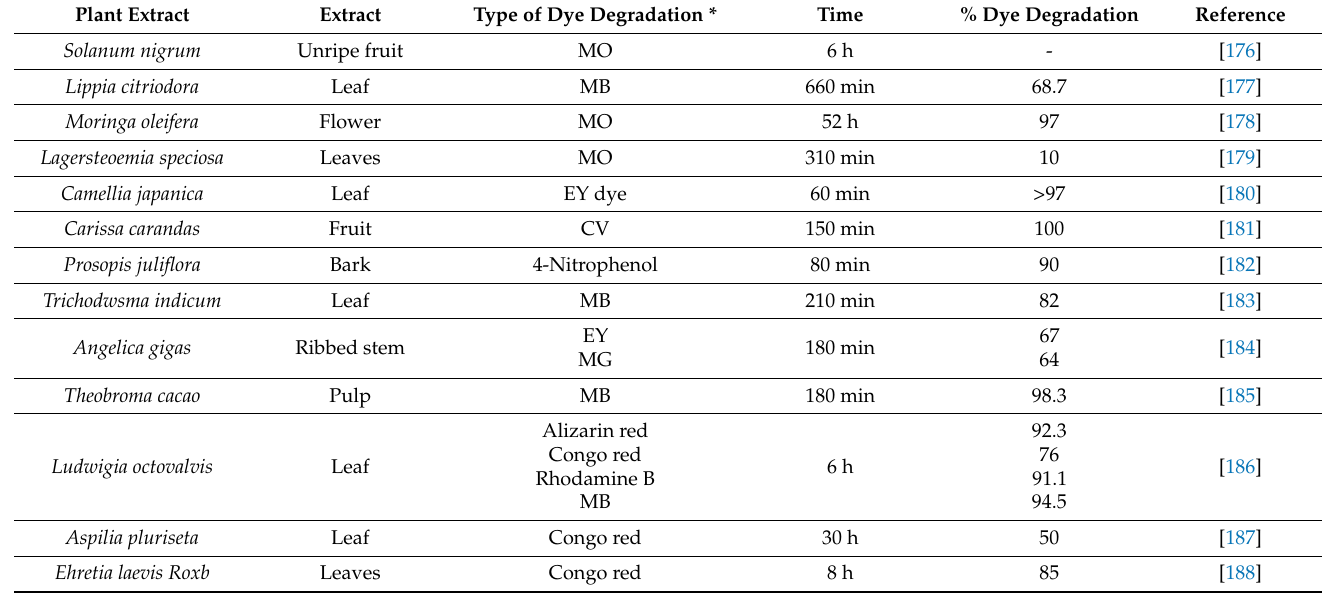
Figure 8. Schematic representation of the mechanism of AgNPs on photocatalytic dye degradation activity. Table 5. Different plant ‐ synthesized AgNPs used for environmental applications.